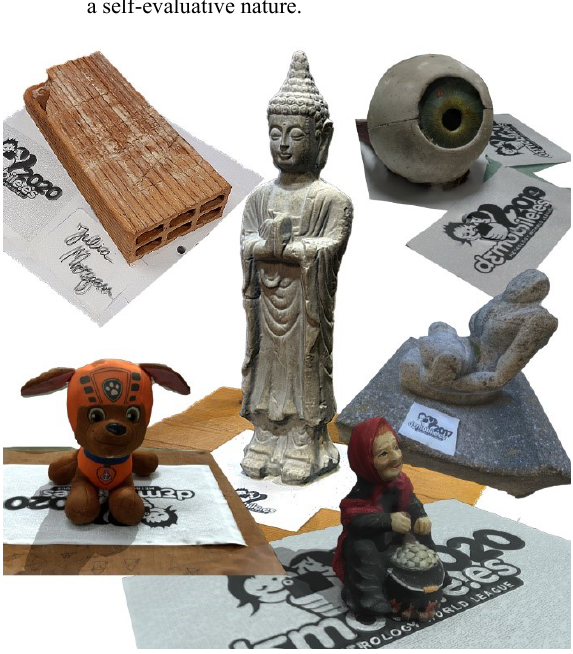
Figure 5. Some samples of scanned objects (available on Sketchfab 6 ). The complete list of winners by category and year can be found at the D3MOBILE website 7